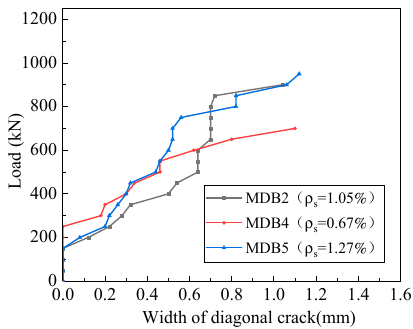
Figure 16. Relation curve between ρ s and maximum crack